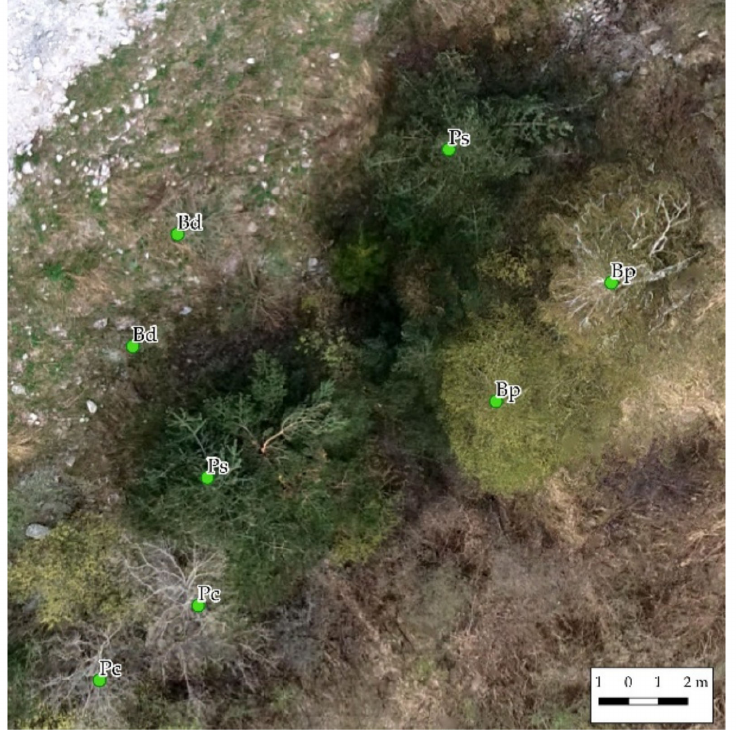
Figure 5. Detail of Pinus sylvestris (Ps) and Betula pendula (Bp) in epoch I (March). The other species (Bd and Pc) are still without